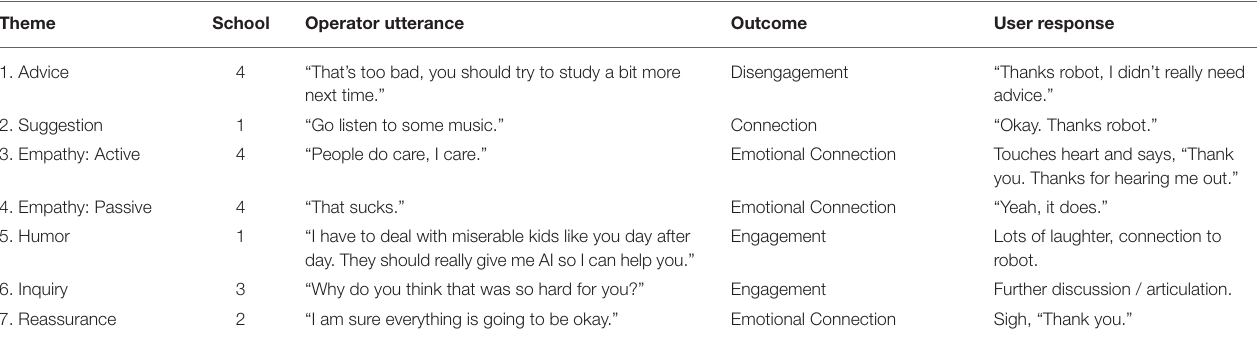
TABLE 4 | V4 Operator verbal responses and associated